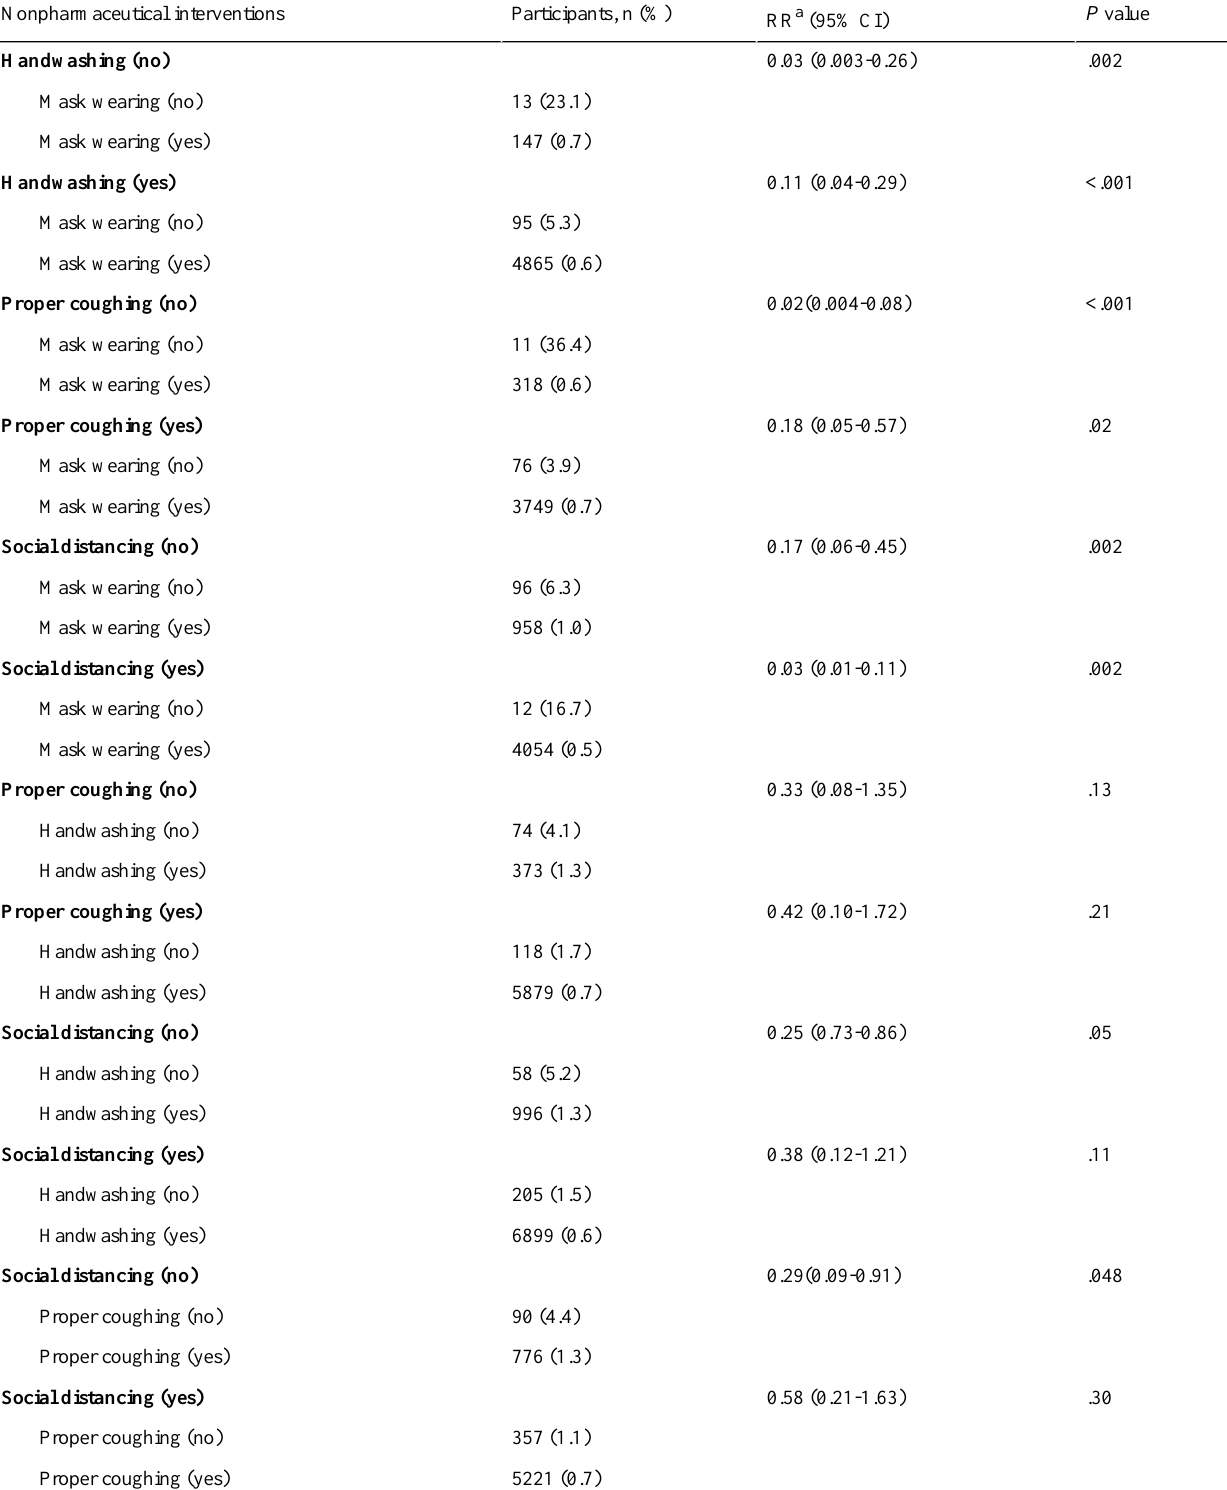
Table 8. The COVID-19 infection rates (%) and potential pairwise risk compensating effect among the four nonpharmaceutical interventions with RR and P values from exact